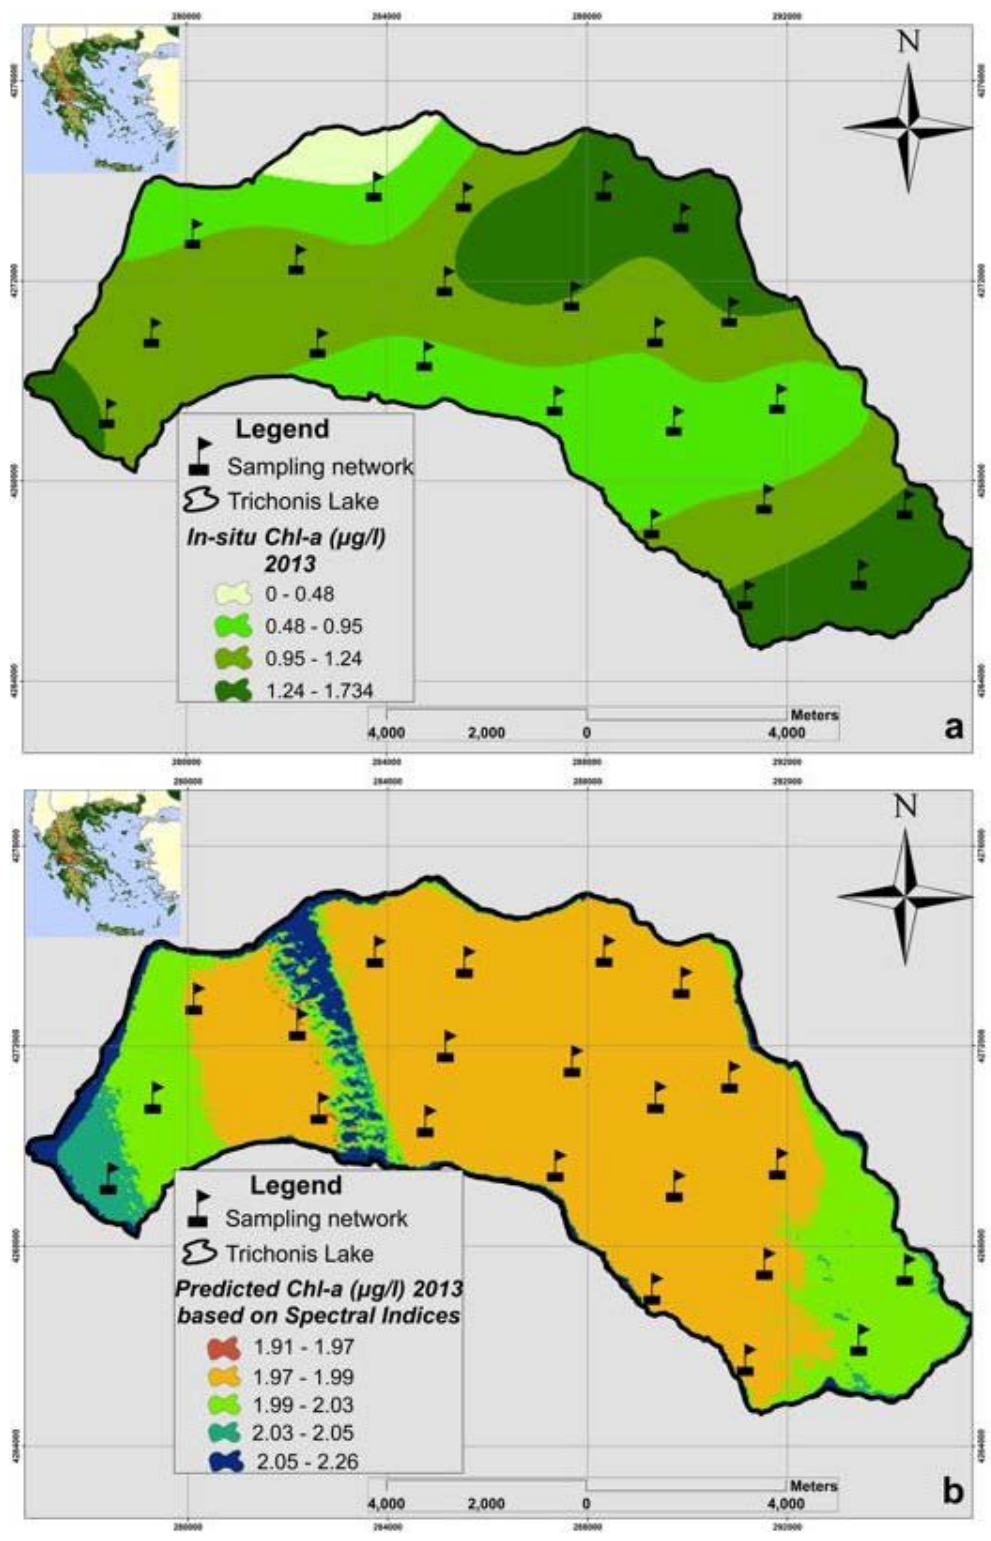
Figure 8. ( a ) In ‐ situ Chl ‐ a ( μ g/L) spatial distribution of 2013 and ( b ) satellite derived Chl ‐ a ( μ g/L) of Figure 8. ( a ) In-situ Chl- a ( µ g/L) spatial distribution of 2013 and ( b ) satellite derived Chl- a ( µ g/L) of 2013 along the Trichonis Lake, after applying the satellite ‐ predictive algorithm using spectral indices. 2013 along the Trichonis Lake, after applying the satellite-predictive algorithm using spectral